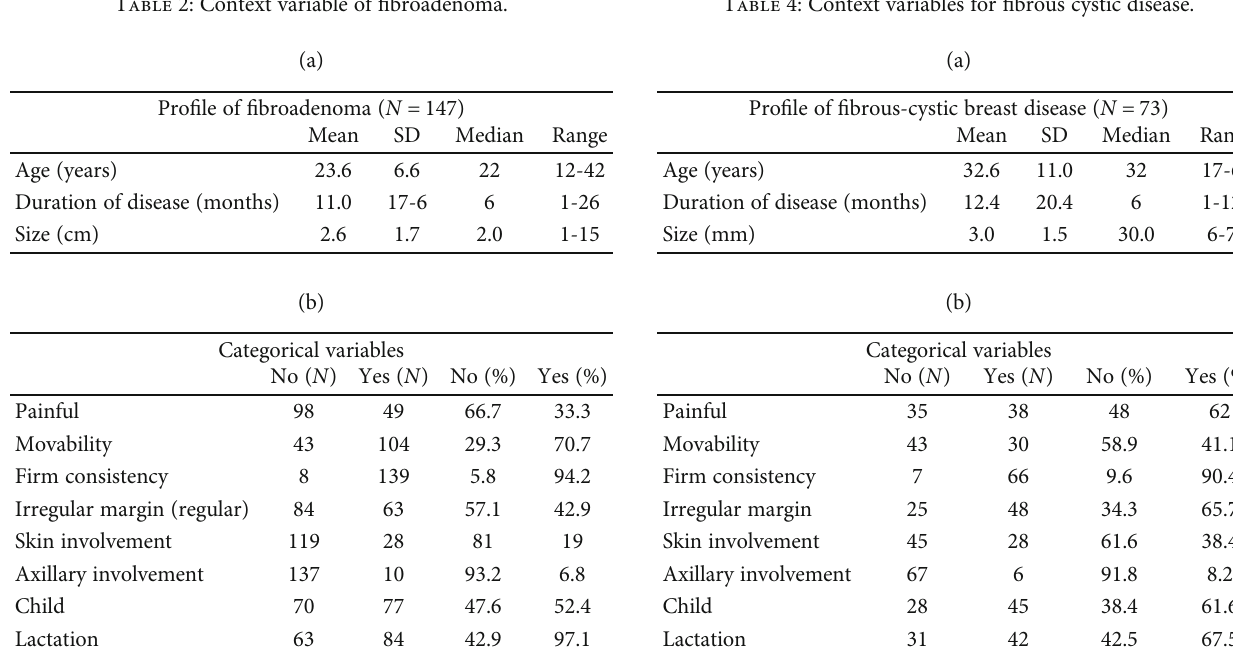
Table 4: Context variables for fi brous cystic